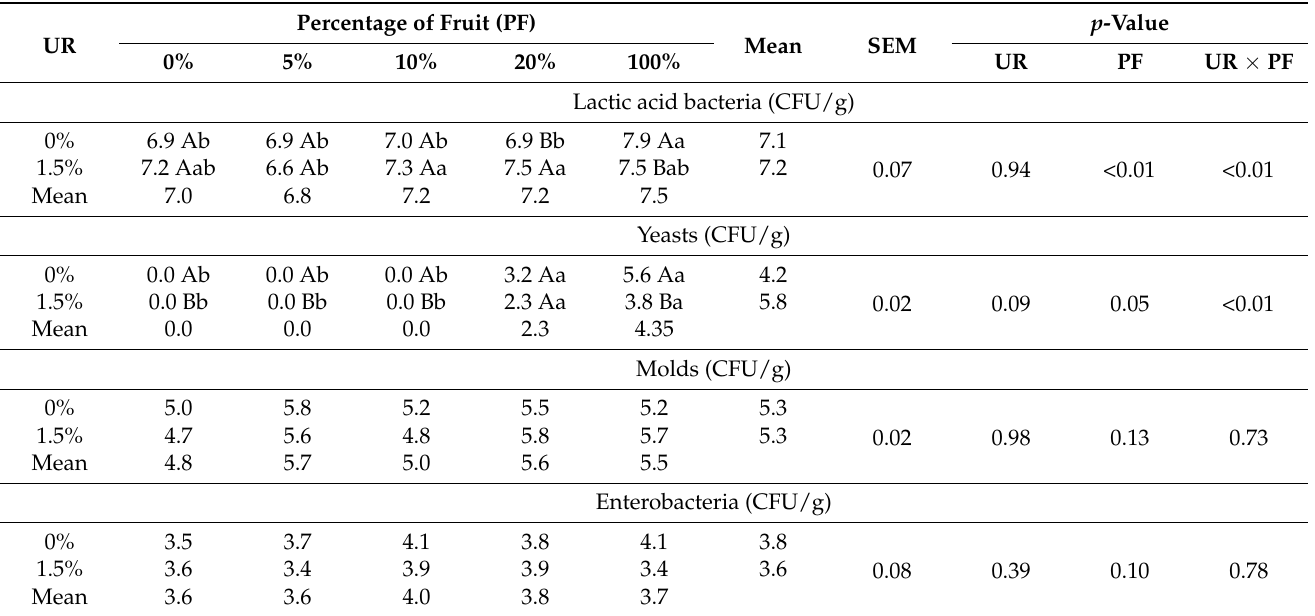
Table 5. Population of microorganisms of silages with different mixtures of melon biomass and addition of